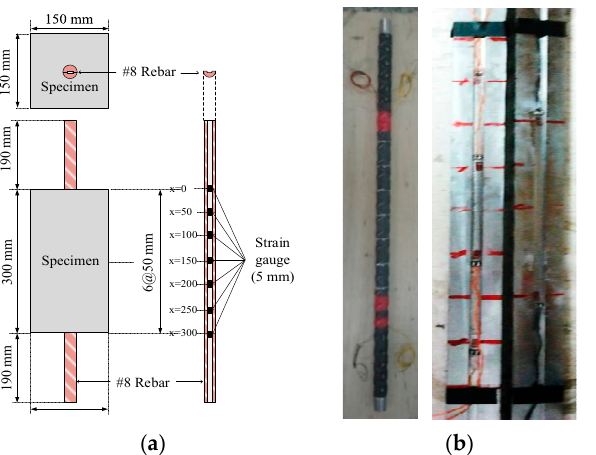
Figure 2. Details of the tension–pull specimen: ( a ) dimensions and cross-section and ( b ) machined #8 rebar. #8